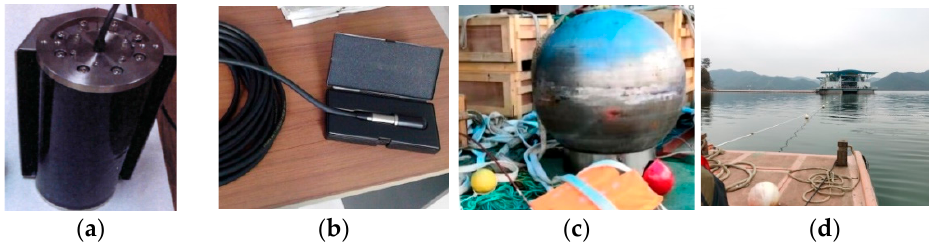
Figure 5. Test device and test scene: ( a ) the source; ( b ) the receiver; ( c ) the target sphere; ( d ) the test scene.